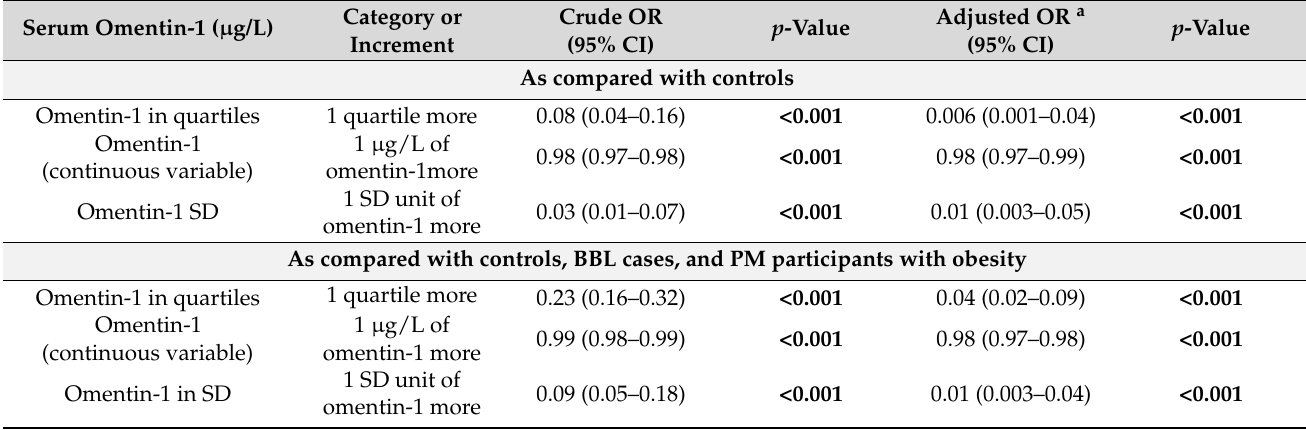
Table 4. Odd ratios (OR) and 95% confidence intervals (CI) for postmenopausal breast cancer in relation to serum omentin-1 by control-defined quartiles, SD and continuously.